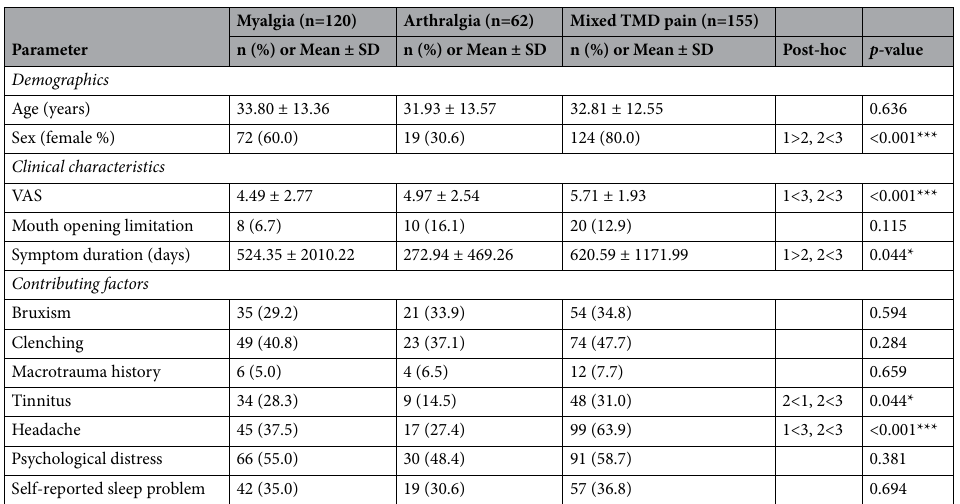
Table 1. Demographic characteristics of TMD patients. The results were obtained from χ 2 test with Bonferroni adjusted post hoc analysis and the mean difference between groups was obtained by ANOVA) with Tukey’s post-hoc test. p -Value significance was set at <0.05. *: p -value <0.05, **: p -value <0.01, ***: p -value <0.001. TMD: temporomandibular disorder, VAS: visual analogue scale, SD: standard deviation, 1 in Post-hoc test: the mean value of myalgia group, 2 in Post-hoc test: the mean value of arthralgia group, 3 in Post-hoc test: the mean value of mixed TMD pain